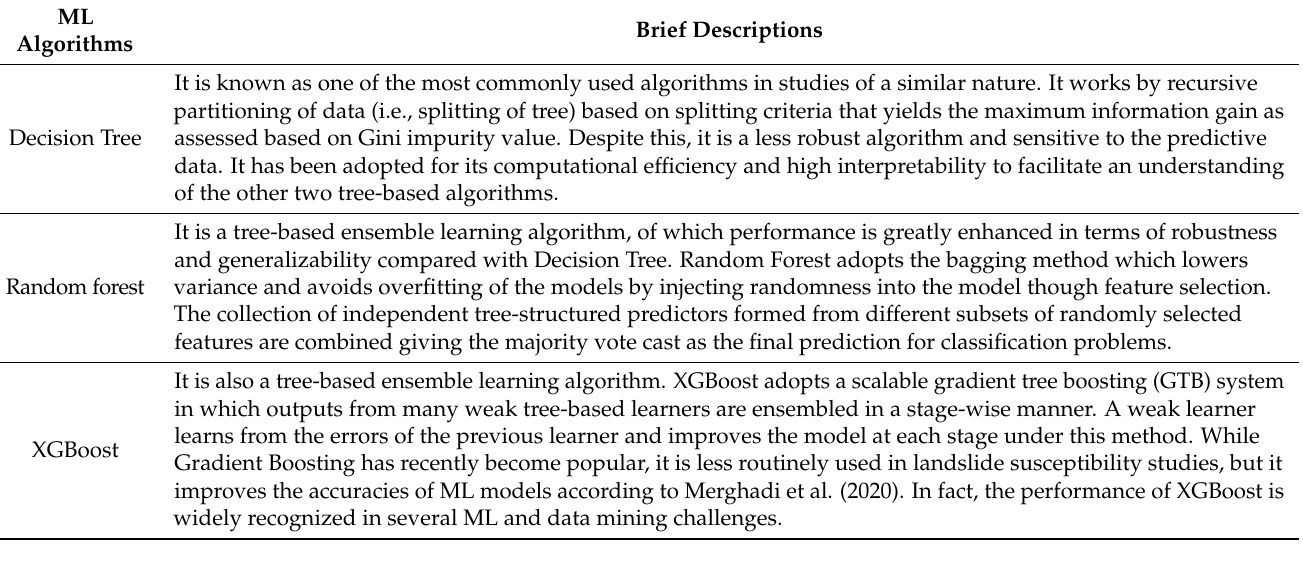
Table 2. Brief description on the selected machine learning